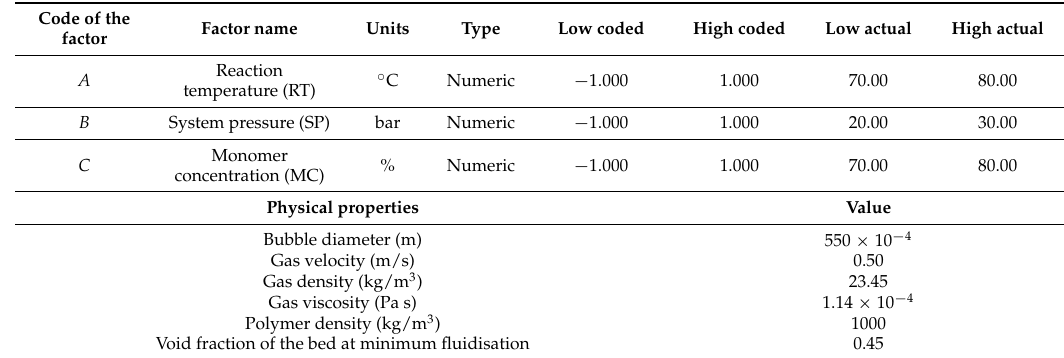
Table 1. Range of the independent process variables employed in the experimental design and physical properties of the reaction